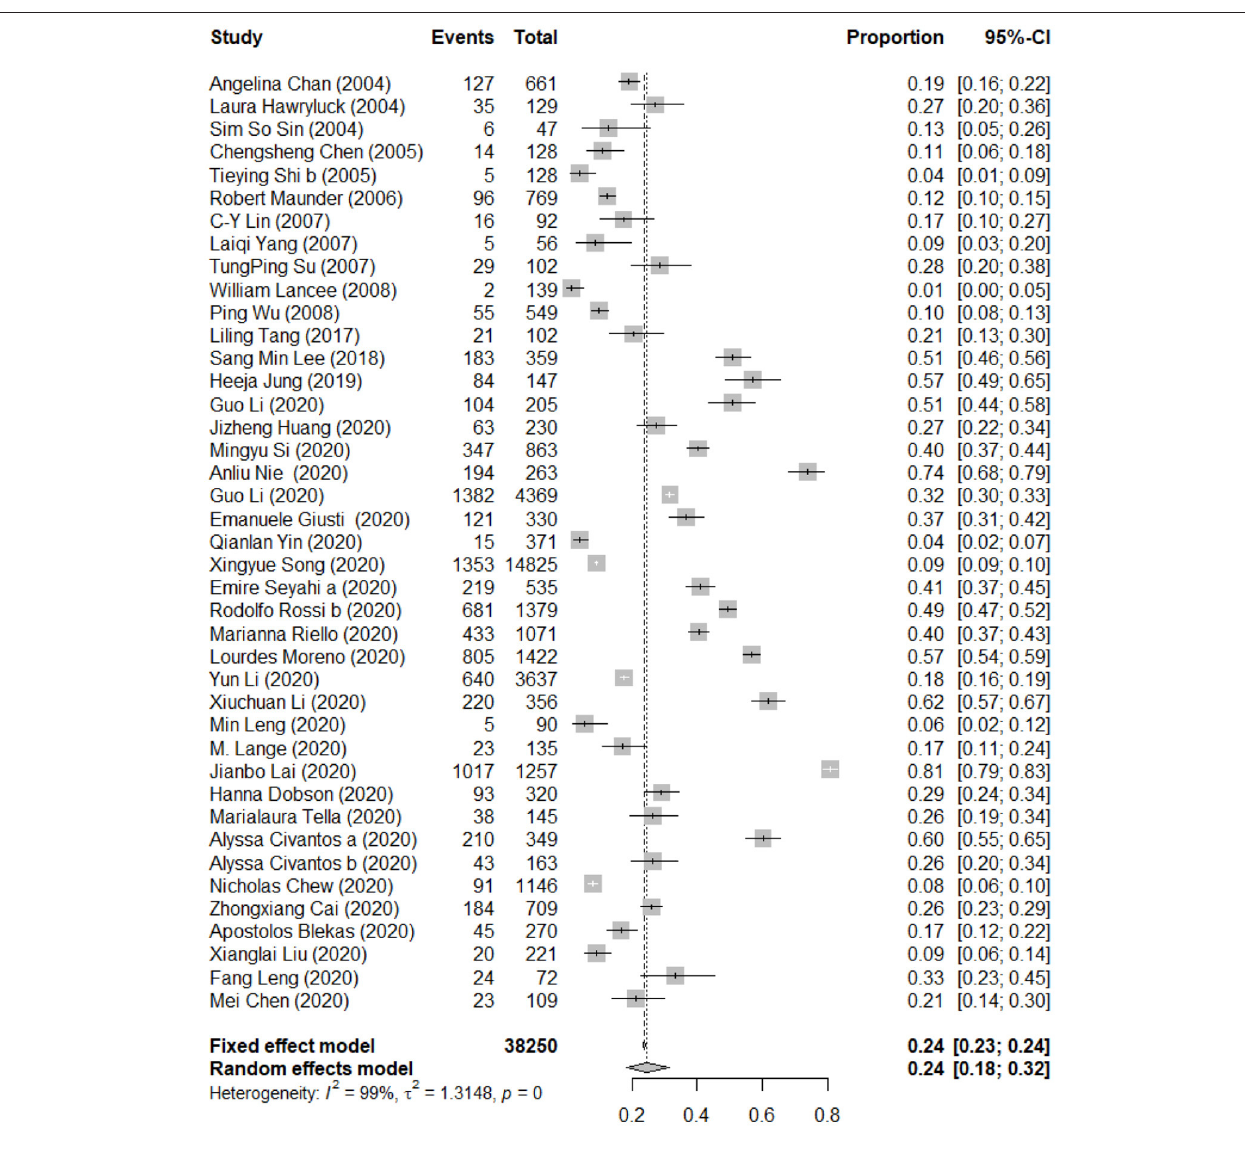
FIGURE 3 | Forest plots of pooled prevalence of post-traumatic stress symptoms among healthcare